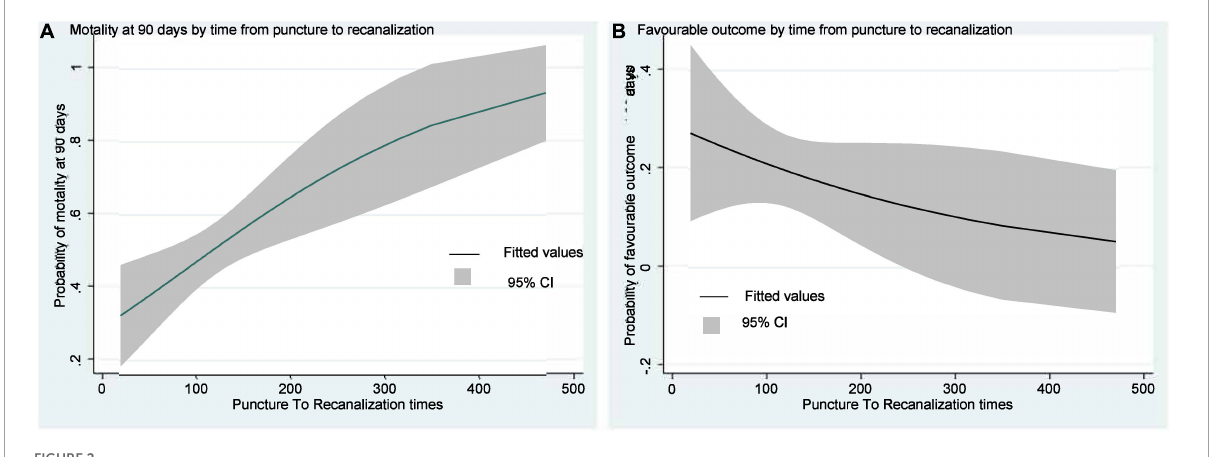
FIGURE2 Curves show the increase in predicted motality probabilities with increases in puncture-to-recanalization time and (A) . The decreases in predicted favorable outcome probabilities with increases in puncture-to-recanalization time (B) .